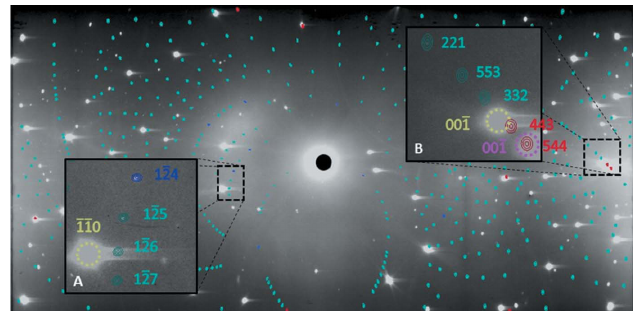
Figure 4 Integrated Laue diffraction pattern of copper sulfate pentahydrate recorded at 0.71 GPa, ’ = (cid:8) 30 (cid:6) , using the mini-DAC. The blue pattern shows the sample ellipses, the darker ones being the model peaks (inset A). Inset B shows rejected sample Laue spots (red) that are very close to or overlapping the diamond reflections. The same colour code and contrast adjustment as those of Fig. 3 were applied.